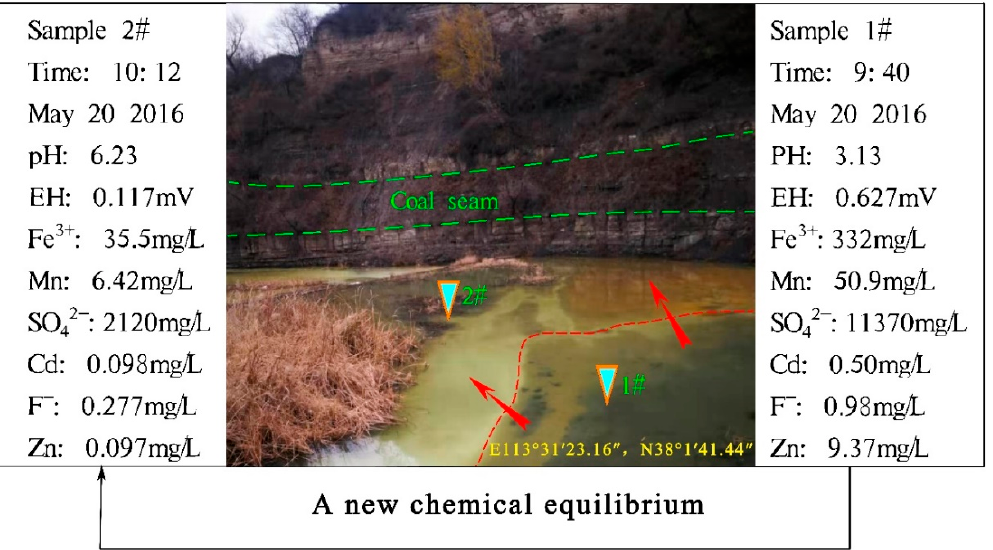
Figure 4. Acid mine drainage (AMD) in Shandi Village, Yangquan, Shanxi.